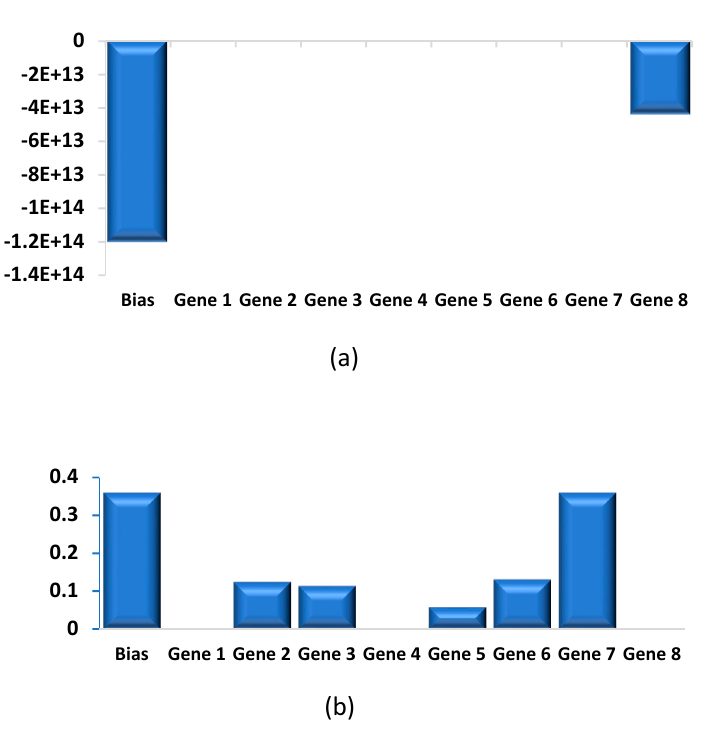
Figure 4. Statistical properties of the evolved MGGP model on the training data ( a ) Gene Weights ( b ) P-Value (low = significant).